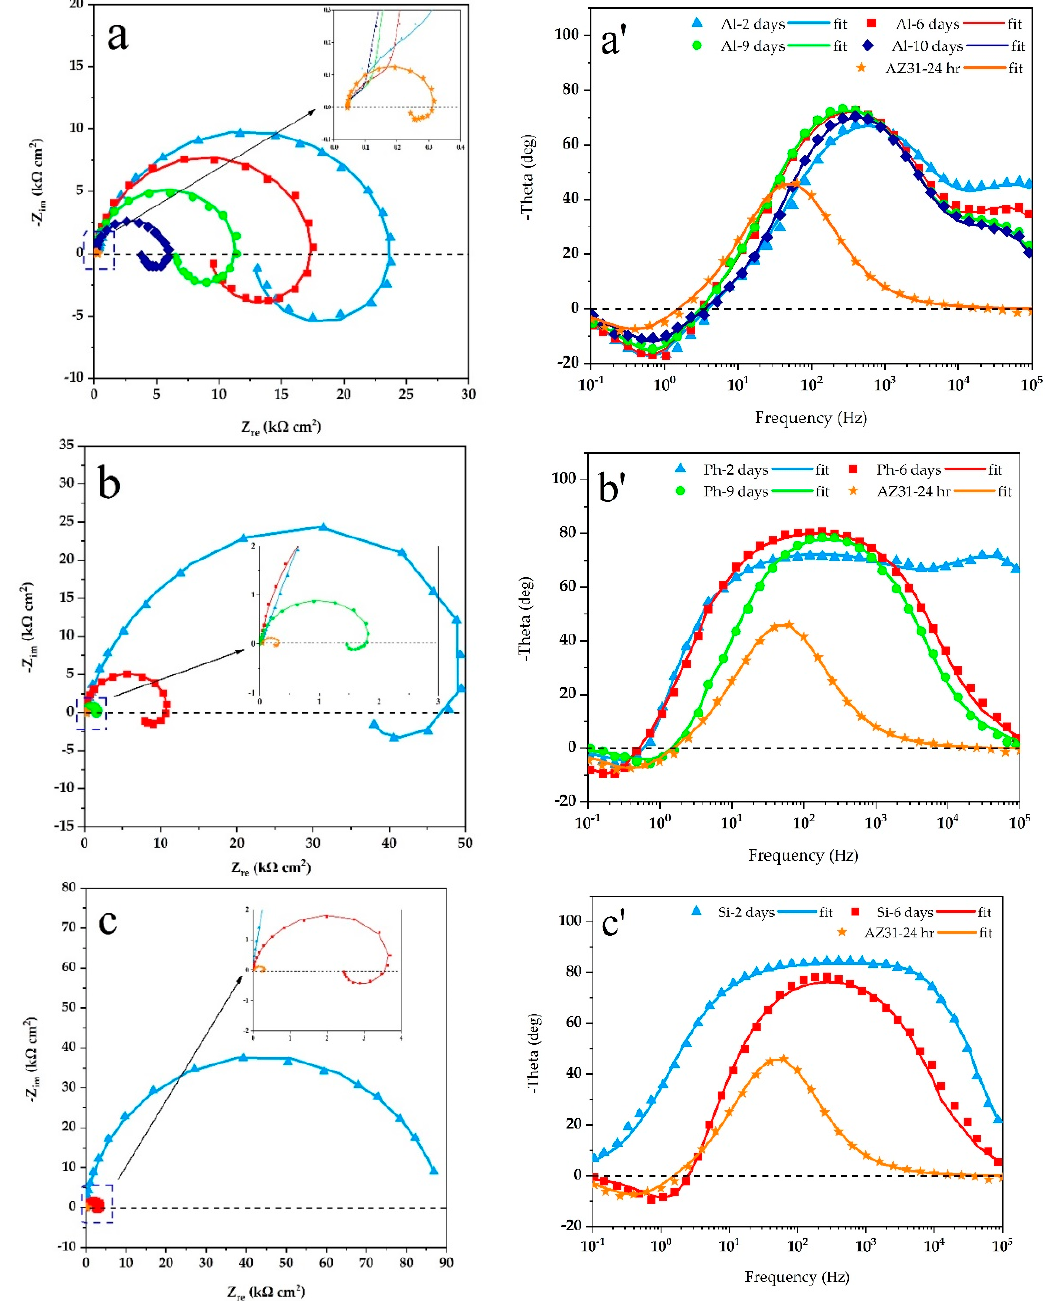
Figure 6. Nyquist and Bode-Phase plots of PEO coatings after long-term exposure in 3.5 wt.% NaCl solution for ( a , a’ ) Al, ( b , b’ ) Ph, and ( c , c’ ) Si.